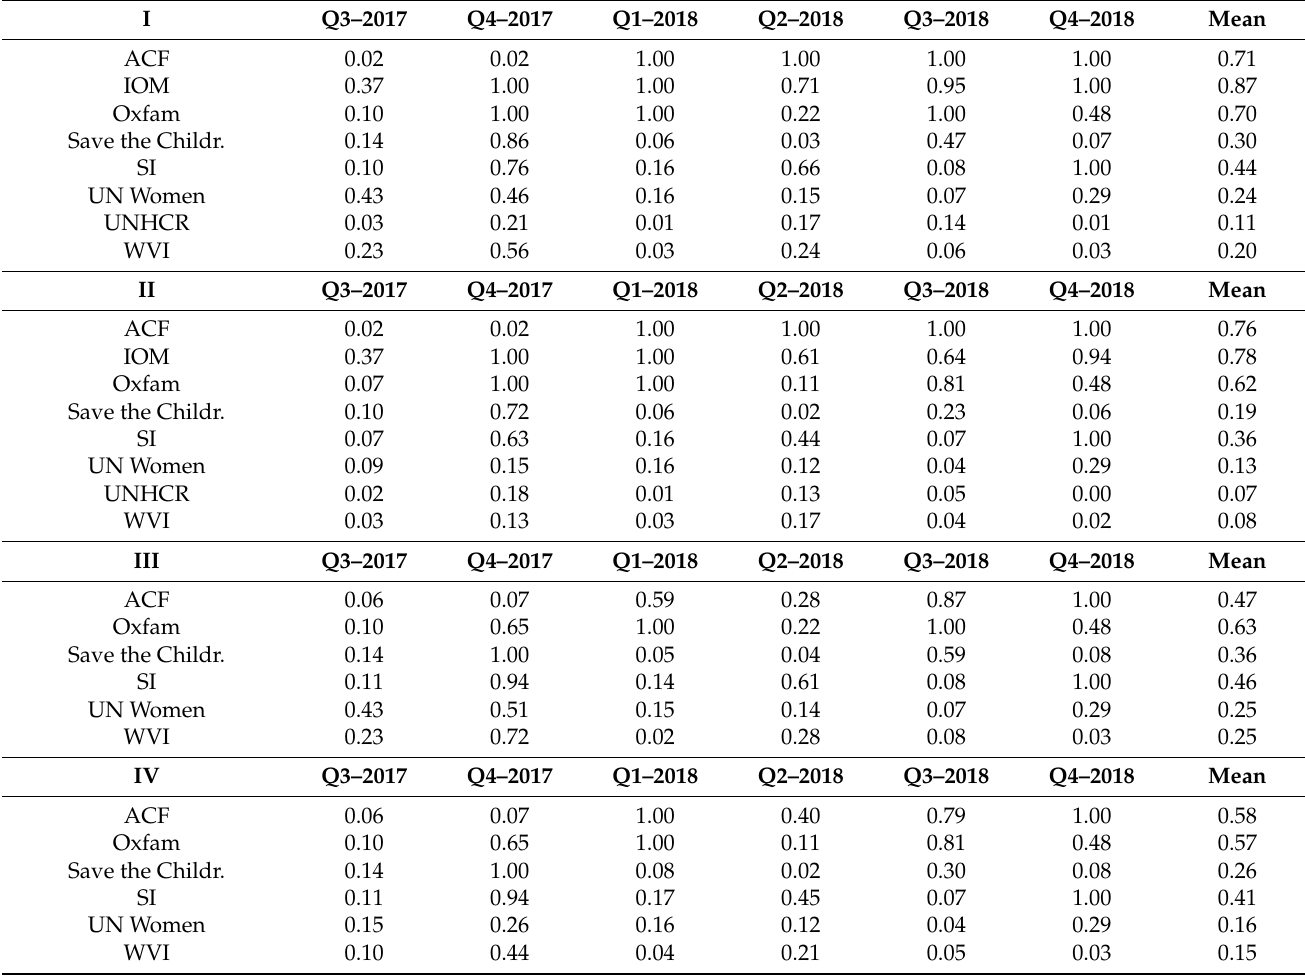
Table 11. Average efficiencies for DEA window analysis